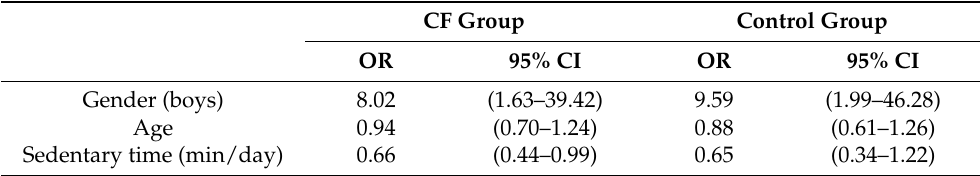
Table 3. Binomial logistic regression to predict the accomplishment of physical activity guidelines by